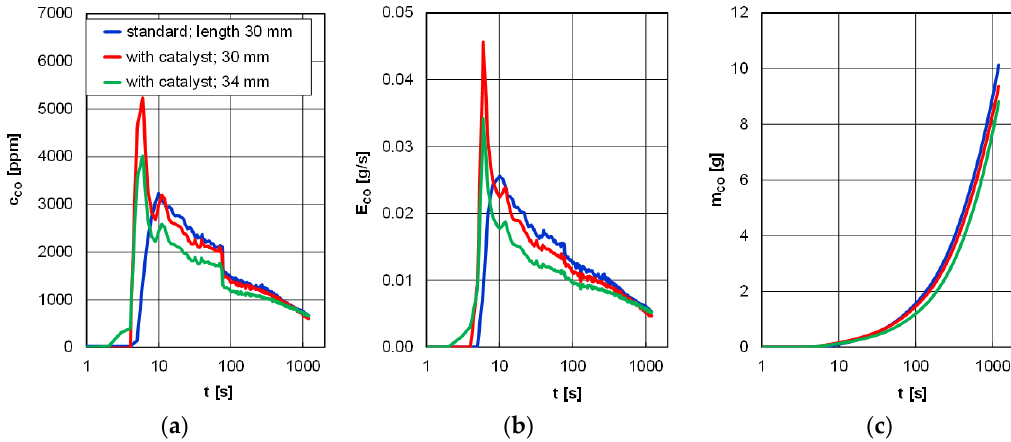
Figure 8. Concentration ( a ), emission rate ( b ), and emission of carbon monoxide ( c ) during the tests of a diesel engine depending on the type of glow plugs and the length of the catalyst-covered ones.